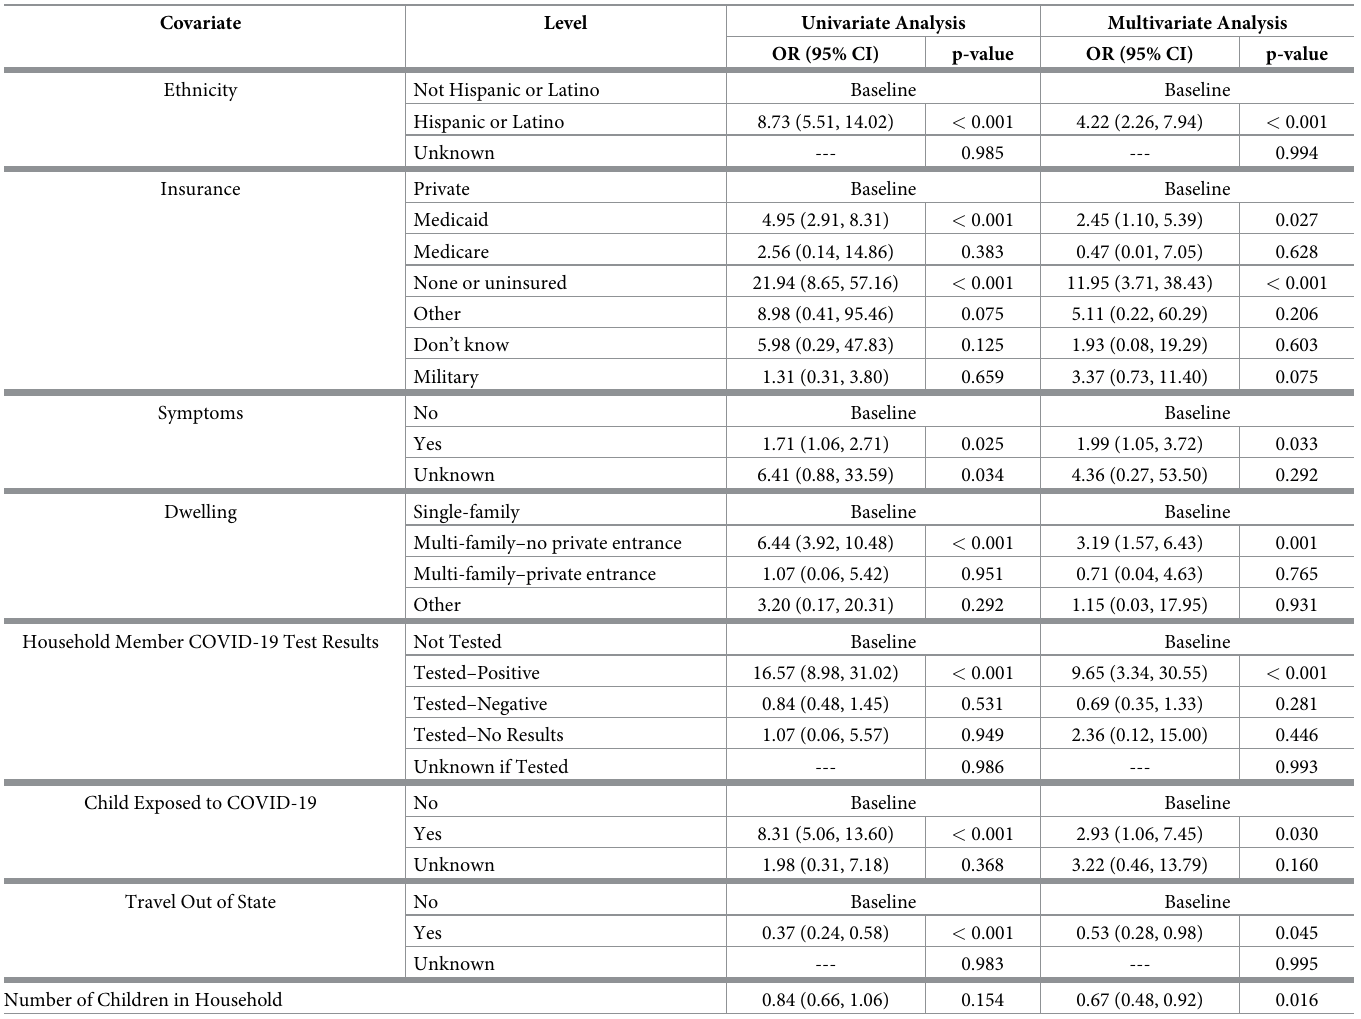
Table 2. Odds ratio estimates and p-values for chosen